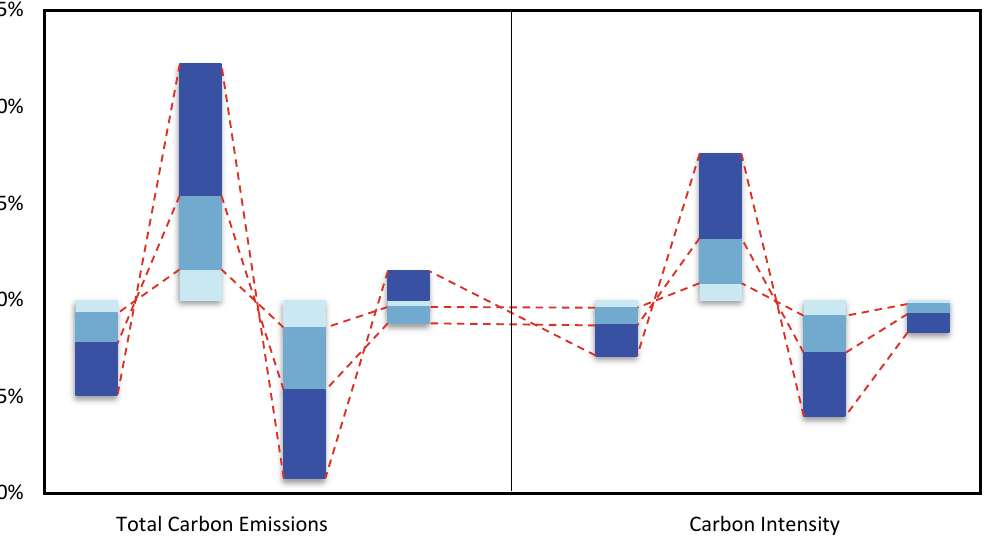
Figure 5. Impact of different scenarios on total carbon emissions and carbon intensity Unit: %.